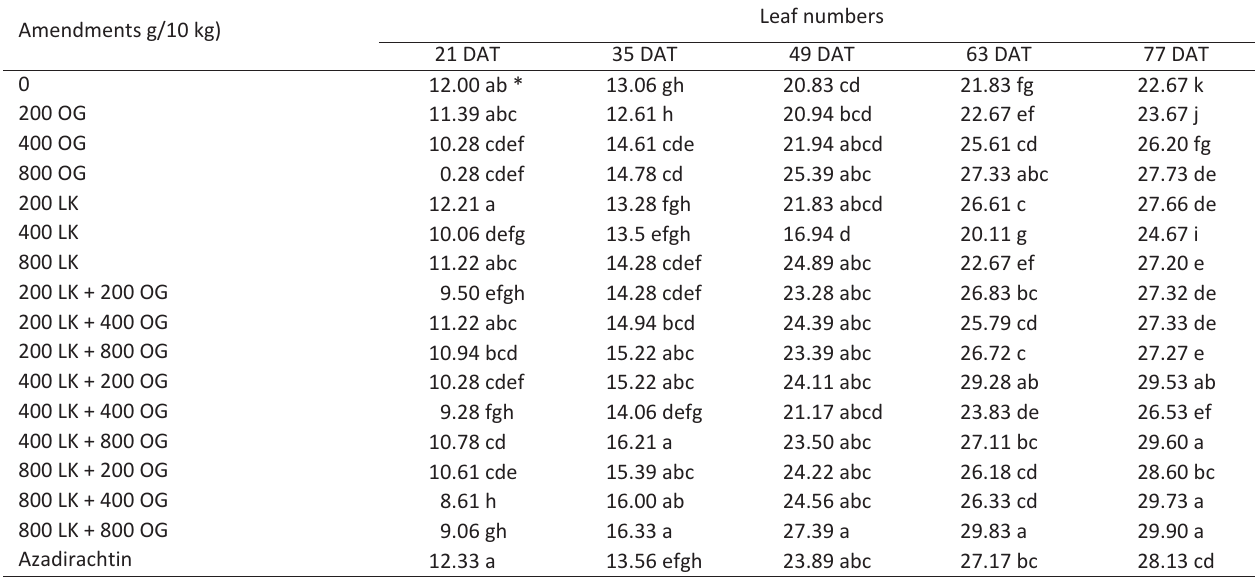
Table 4 ­ Effect of fresh plant biomass on tomato leaf numbers